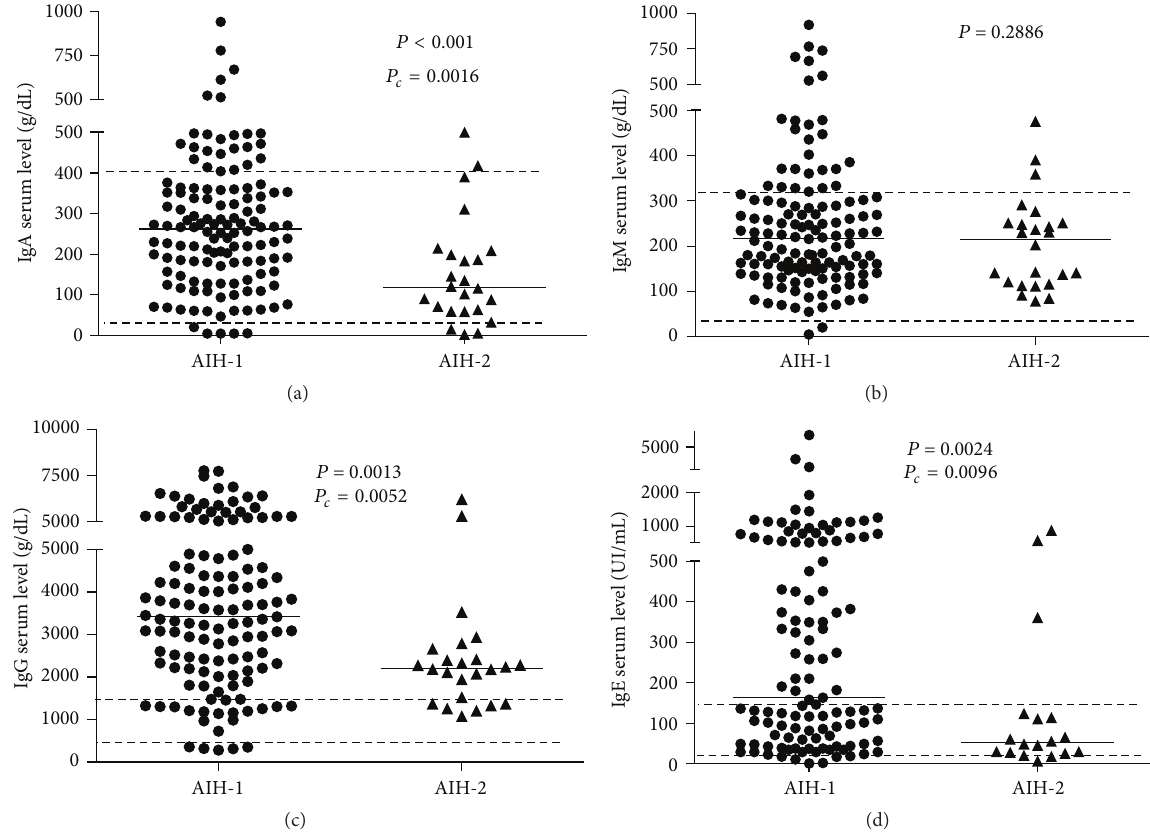
Figure 1: Immunoglobulins concentrations according to autoimmune hepatitis type. (a) IgA (g/dL); (b) IgM (g/dL); (c) IgG (g/dL), and (d) IgE (UI/mL). The immunoglobulins concentrations were assessed by nephelometry. Statistical analysis by Mann-Whitney nonparametric test (for